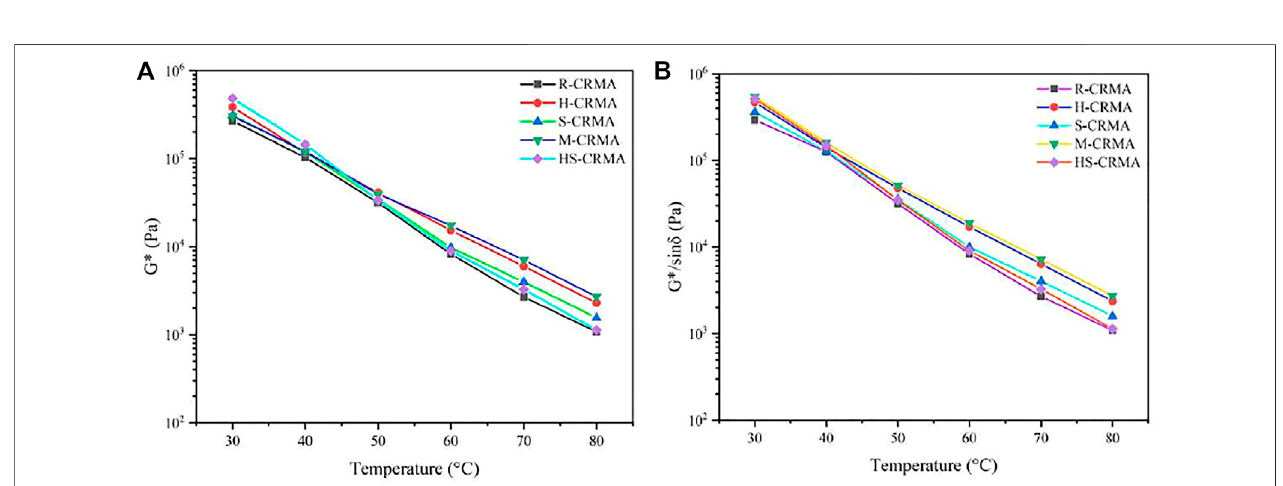
FIGURE 5 | The temperature sweep results of DSR at 10 Hz. (A) The complex modulus G*; (B) the rutting factor G*/Sin δ .